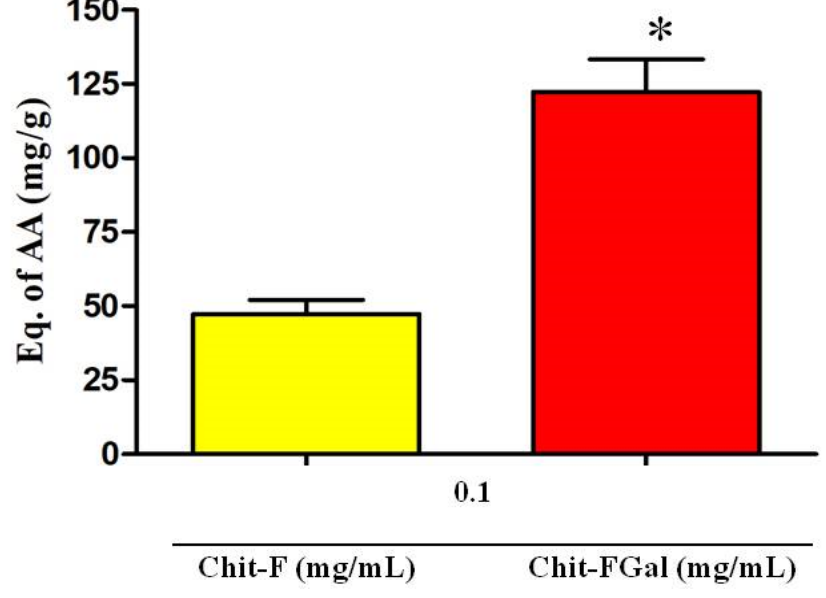
Figure 7. Total antioxidant capacity (TAC) test of Chit-F and Chit-FGal. * indicates significant difference between the samples ( p < 0.05).